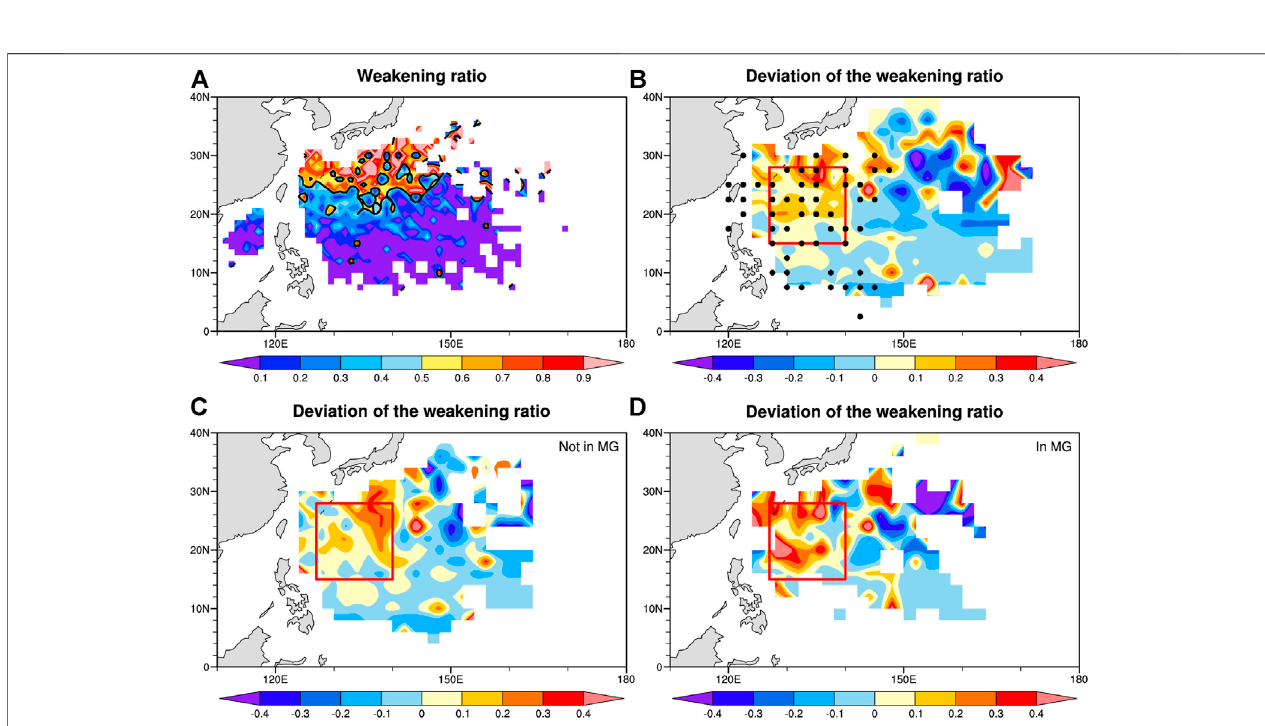
FIGURE4|(A) TCweakeningratio(shadings)during2000 – 2018,solidblackcontouristheweakeningratioof0.5 (B) Thedeviationoftheweakeningratiofromthe zonal average between 120 ° E and 180 ° E, with black dots being the locations of MGs, and red rectangle outlining the active region of MGs (C) The deviation of the weakening ratio from the zonal average during the non-MG period (D) The deviation of the weakening ratio from the zonal average during the MG period.